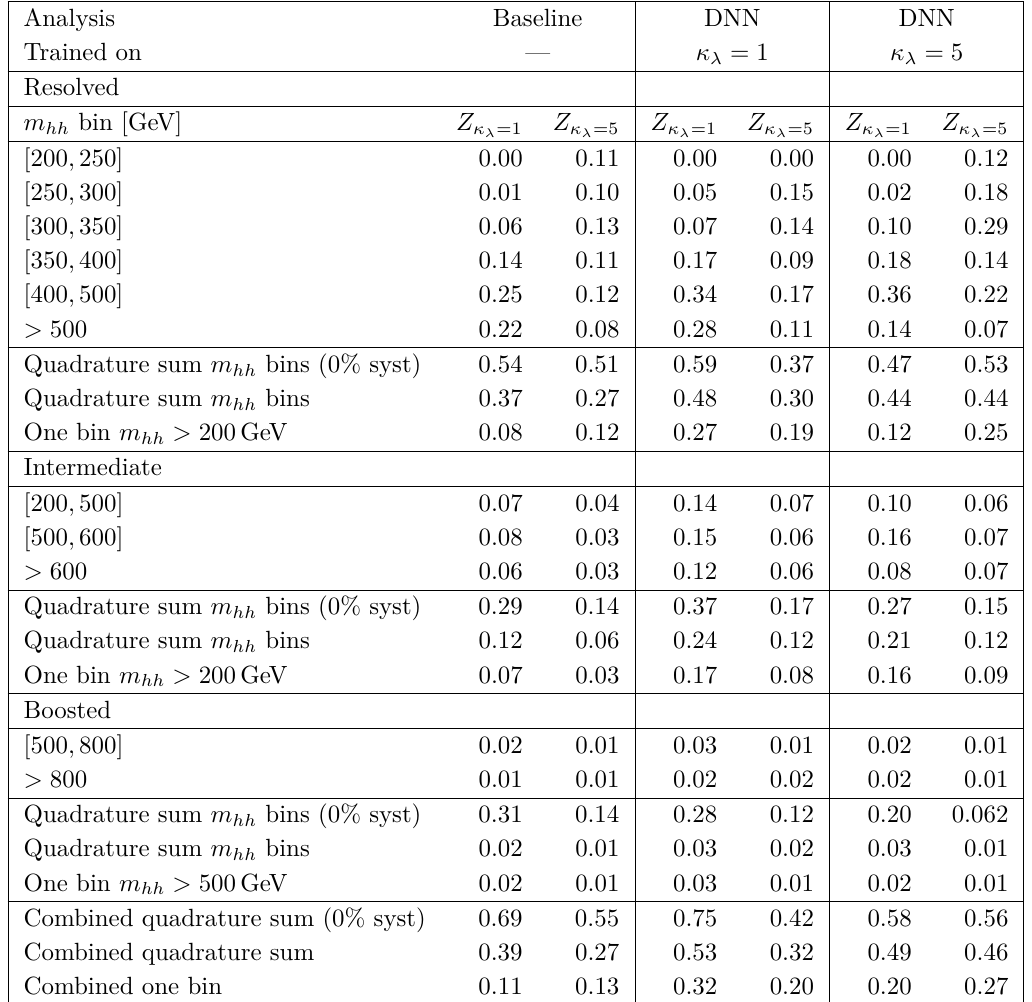
p Table 7. Statistical significances defined by Z = S/ B + ( ζ b B ) 2 for L = 3000 fb − 1 using the signal and background counts of table 5. Here, Z i corresponds to using the κ λ = i signal samples and the nominal systematics ζ b are taken from table 6. These are evaluated for the baseline analysis, the DNN analysis where the DNN was trained with the κ λ = 1 and κ λ = 5 samples. The results are shown for the resolved, the intermediate and boosted categories which are separated by the corresponding headings. The lowest two rows of each category presents the significances combined by the ‘quadrature sum’ of the significances binned in m hh , and second ‘one bin’ sums the yields into one inclusive bin before calculating Z . The bottom three rows shows significances combined across all three